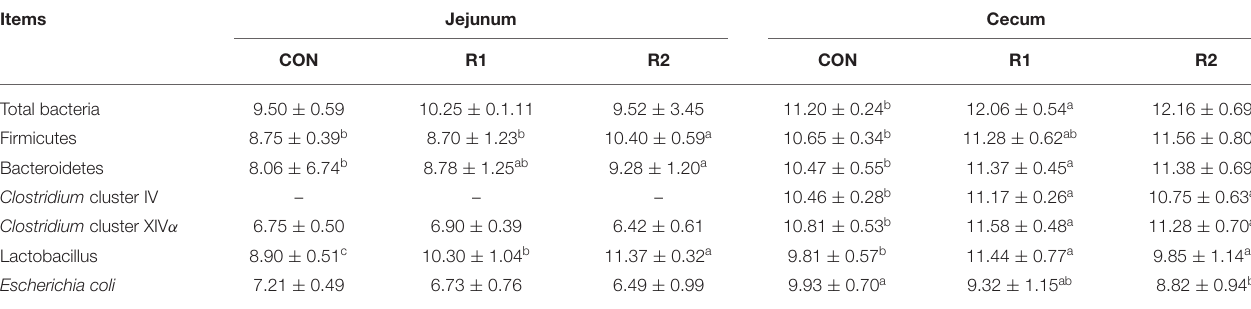
TABLE 7 | Effects of CAT on the intestinal microbial composition of 30-day old yellow broilers. Items Jejunum Cecum CON R1 R2 CON R1